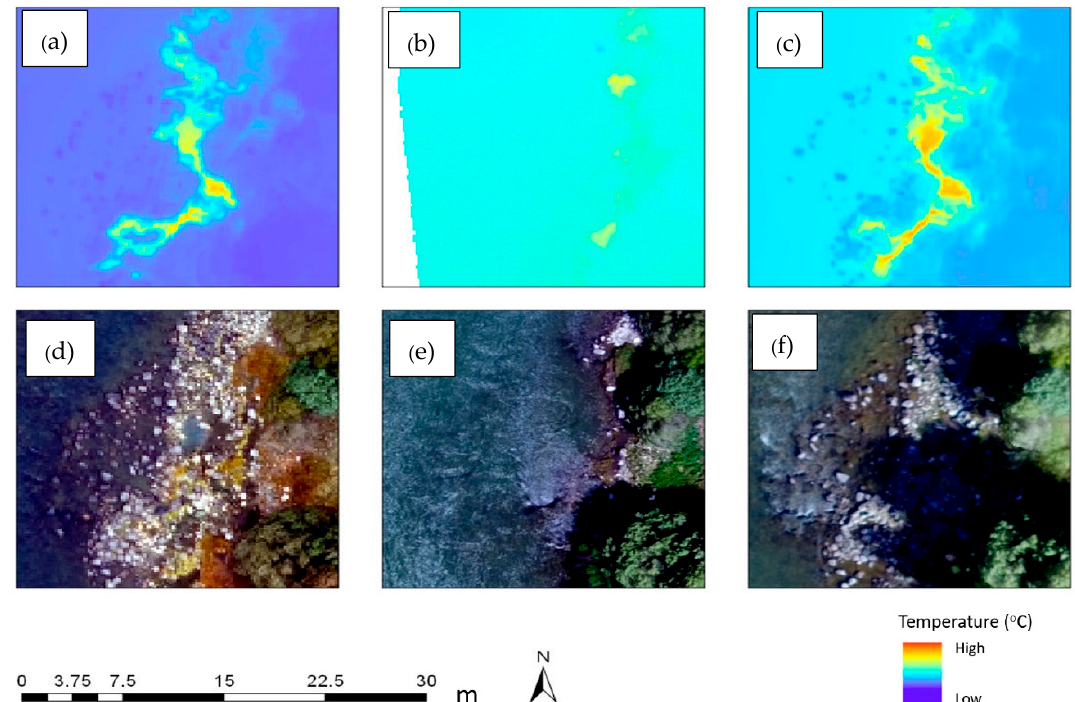
Figure 12. Temporal variation of geothermally influenced area for a seep. From left to right—November 2018, July 2019, September 2019. The top row ( a – c ) is a segment of the thermal orthomosaics and the bottom row ( d – f ) is a segment of the RGB orthomosaics. The seep locaiton is marked in the Figure A5.